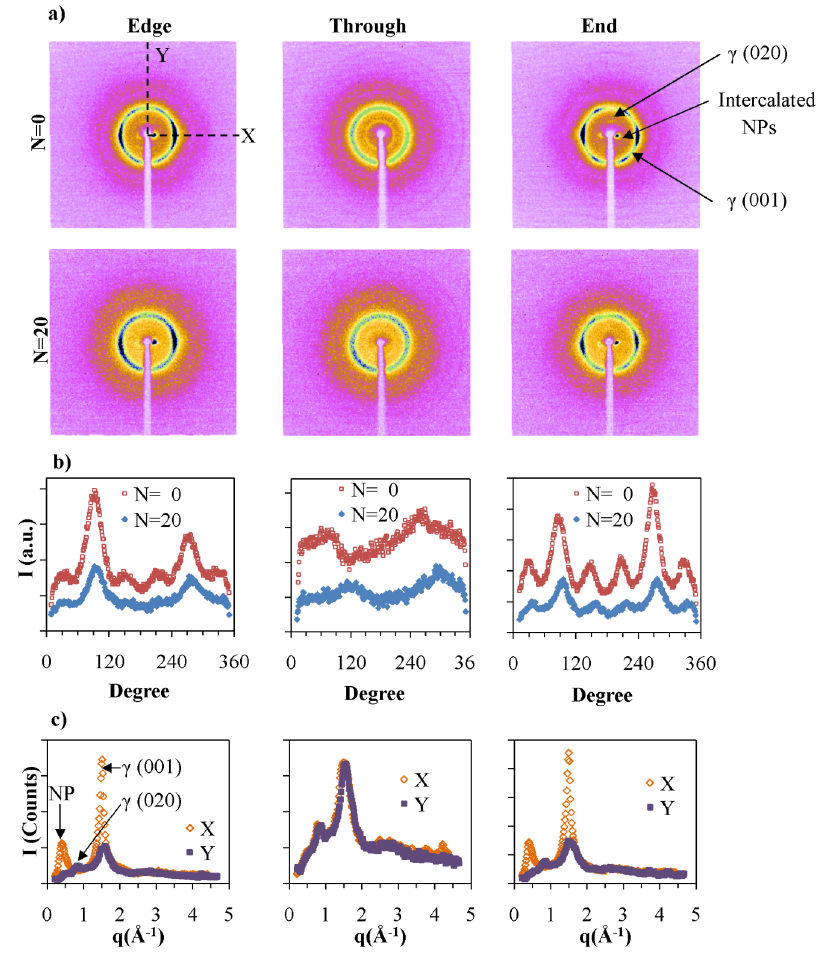
Figure 9. ( a ) Two dimensional X-ray patterns of PA6 with 5.6 vol % NP nanocomposite films at N = 0 and N = 20 from edge, through and end directions; ( b ) The intensity along the γ crystalline ring marked in γ for the different directions; and ( c ) The cross sections of the N = 0 along X and Y